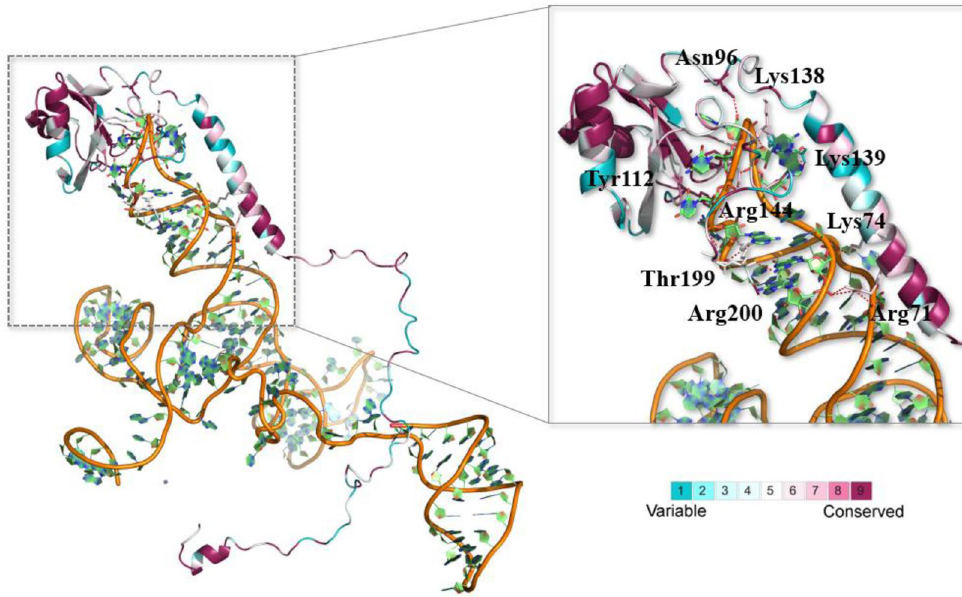
Figure 6. The evolutionary conservation analysis of amino acid positions in animal U1-70Ks. The crystal structure of human U1-70K (PDBID: 6QX9) with its target RNA was shown. The ribbon representation is colored according to ConSurf Grade (1-blue to 9-purple) by using all identified protein sequences of animal